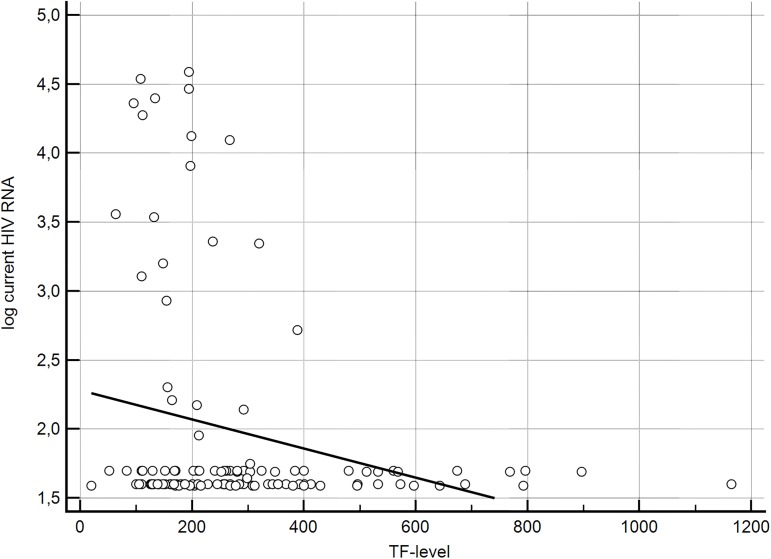
Graphic presentation of the dependency of TF level and HIV RNA level.